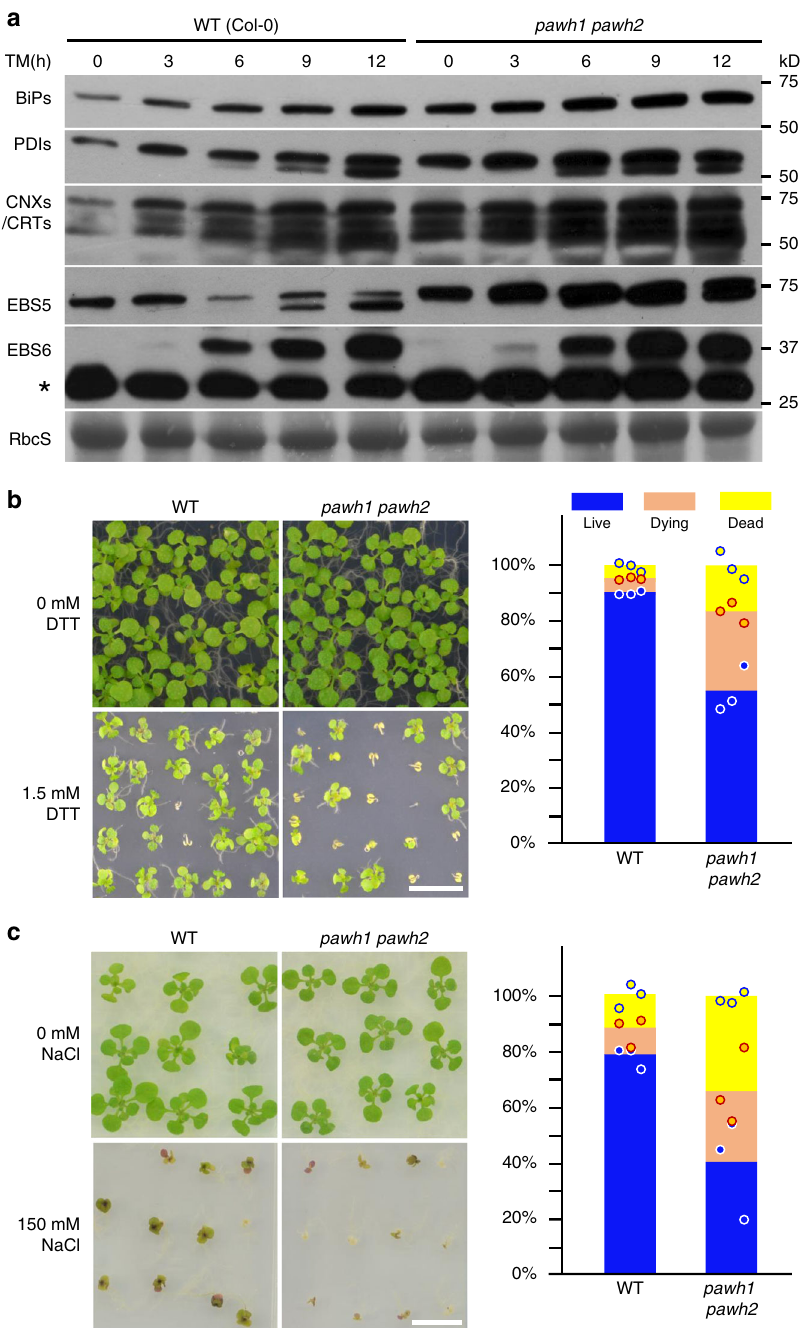
Fig. 4 The pawh1 pawh2 mutation activates UPR and reduces stress tolerance. a Immunoblot analysis of various ER-localized proteins in seedlings treated with TM for different durations. The faster moving bands detected by anti-PDI and anti-EBS5 antibody are non-glycosylated forms of PDIs and EBS5, respectively. The star indicates a non-speci fi c band. The lower strip is the Ponceau Red-stained RbcS bands used as the loading control. b , c The left are photographs of 15-day-old Arabidopsis seedlings grown on ½ MS medium supplemented with or without 1.5 mM DTT ( b ) or 150 mM NaCl ( c ), while the right are the bar graphs showing the percentage of three kinds of seedlings: blue (alive), brown (dying), and yellow (dead). Scale bar = 1 cm. The stress sensitivity experiments were repeated three times with ~100 seedlings/each for the DTT assay and ~50 seedlings/each for the NaCl experiment with individual data points shown as open circles distributed above or below the average values of the three repeats. Source data are provided as a Source Data fi mutations often result in constitutive activation of the Arabi- activates UPR, we performed an immunoblot analysis with total dopsis unfolded protein response (UPR) pathway 36 – 39 , a highly proteins of the wild-type and pawh1 pawh2 mutant treated with conserved ER stress response pathway that upregulates produc- or without TM for variable durations. Figure 4a shows that the tion of ER chaperones and ERAD components to maintain protein abundance of BiPs, protein disul fi de isomerases (PDIs), proteostasis 54,55 . To examine if the pawh1 pawh2 mutation also calreticulins/calnexins (CRT/CNXs), EBS5, and EBS6 was higher